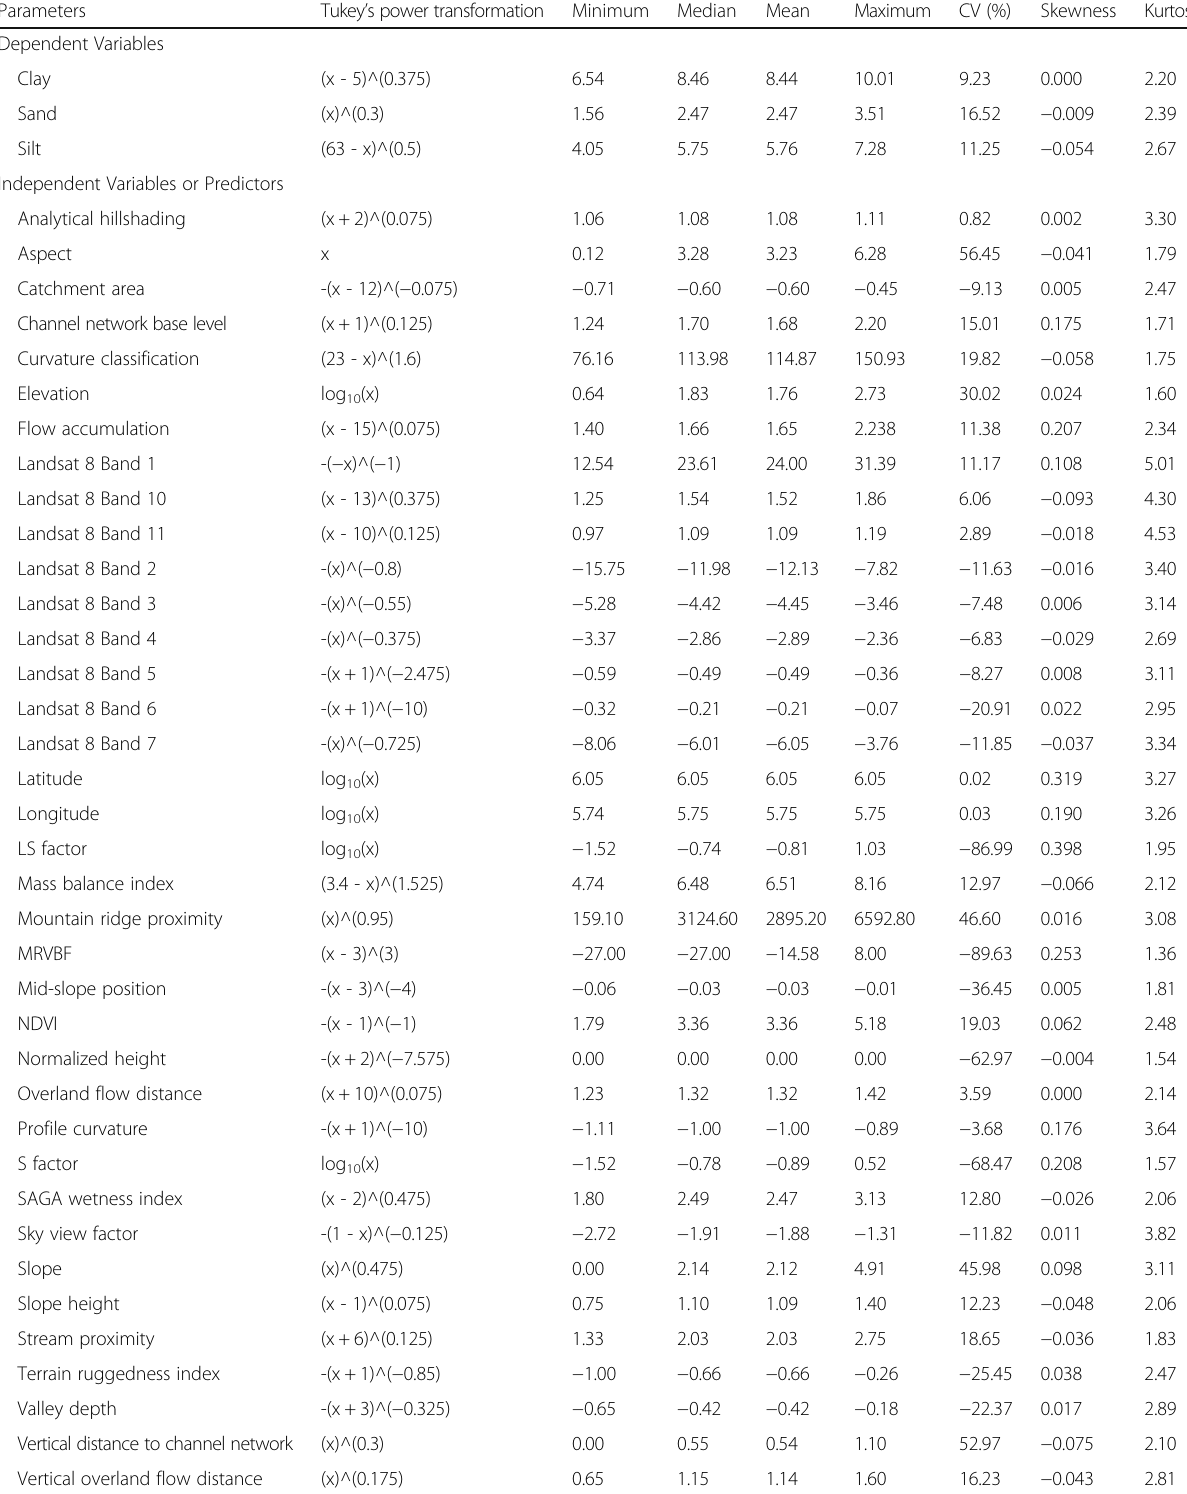
Table 2 Descriptive statistics of transformed variables and the corresponding